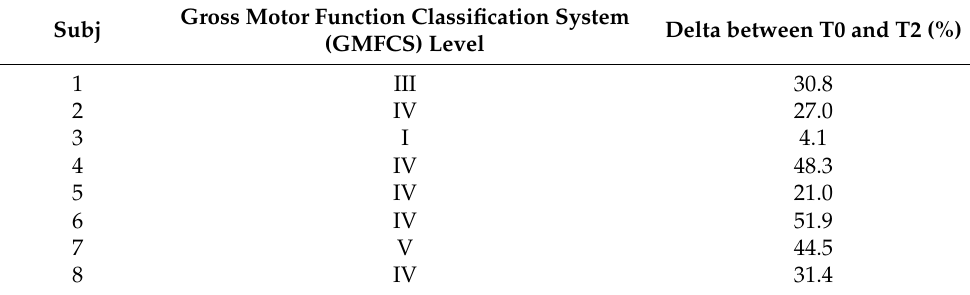
Table 3. GMFM-88 improvement for each participant between T0 and T2 in response to RAGT.